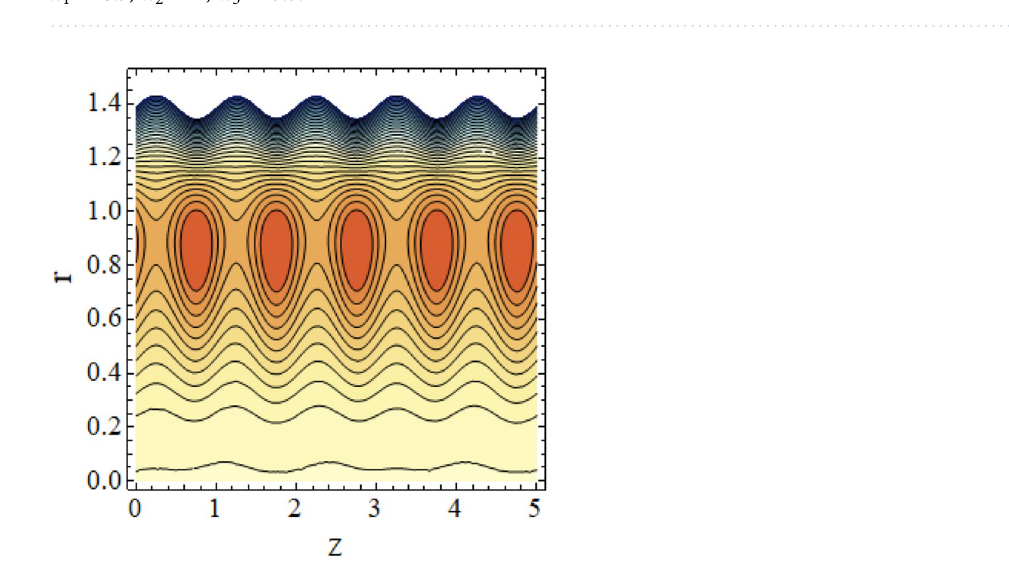
Figure 16. Streamlines for σ l = 0.01 with (cid:31) 1 = 0.4, φ = 0.037, a = 0.01, z d 1 = 0.5, z d 2 = 2, z d 3 = 3.5, h 1 = 0.5, h 2 = 2, h 3 = 3.5, Q =